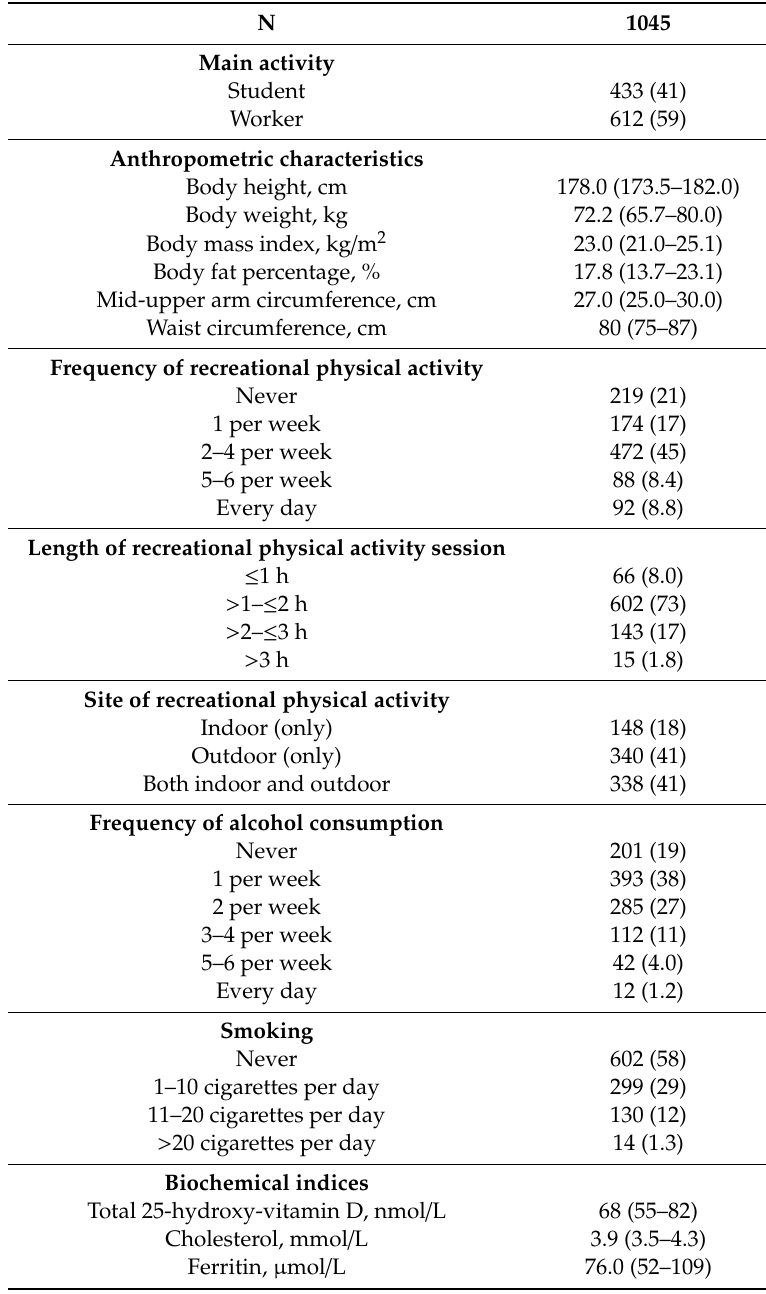
Table 1. Baseline characteristics of the enrolled subjects. Data are given as absolute frequency (and percentage) or median (and interquartile